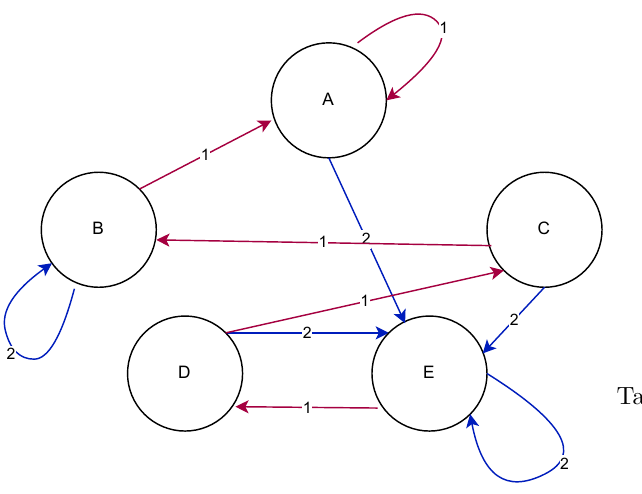
Figure 1: Example graph showing the state-action transitions. Here, the nodes are the 5 states A-E and the edges are the actions. There are 2 possible actions, action 1 (red) and action 2 (blue). The agent does not have knowledge about the transitions prior to exploration.